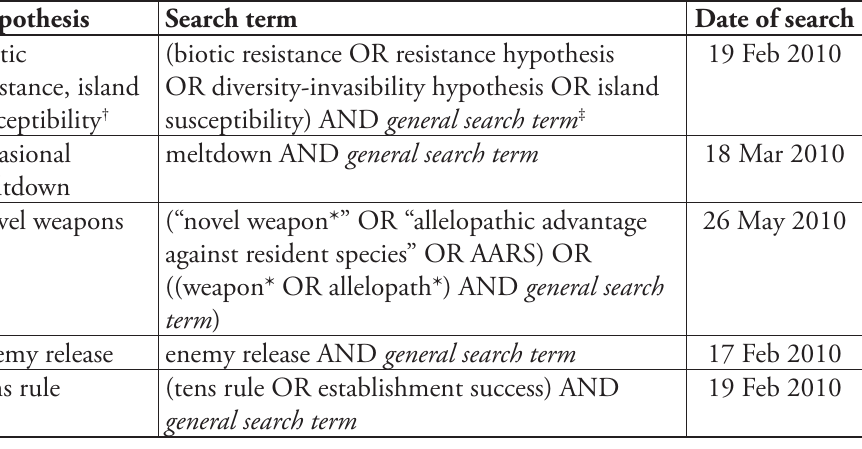
table 1 . Search terms for